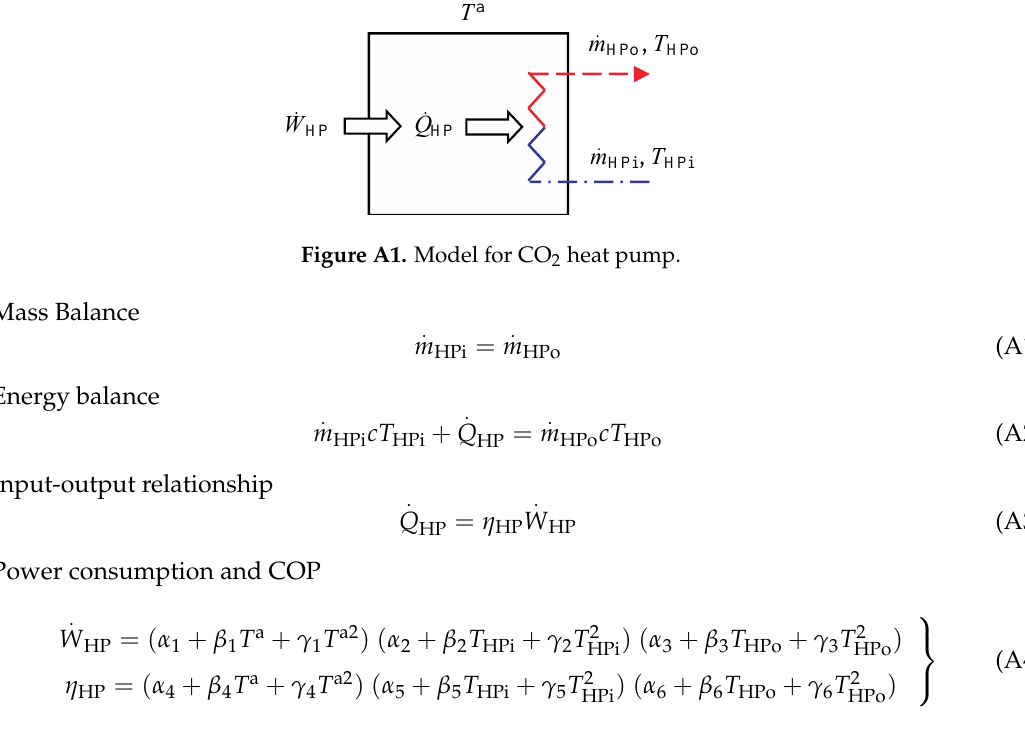
Figure A2. Model for mixing valve. Mass balance